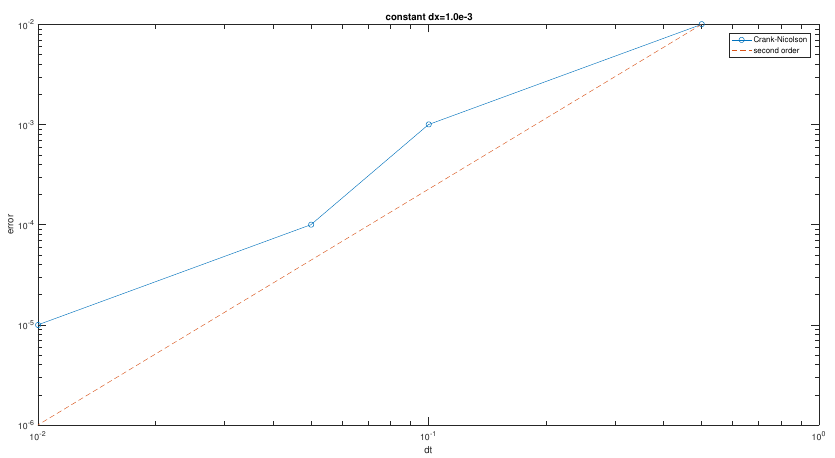
in L 1 -norm as a function of u e u approx (cid:107) − (cid:107)